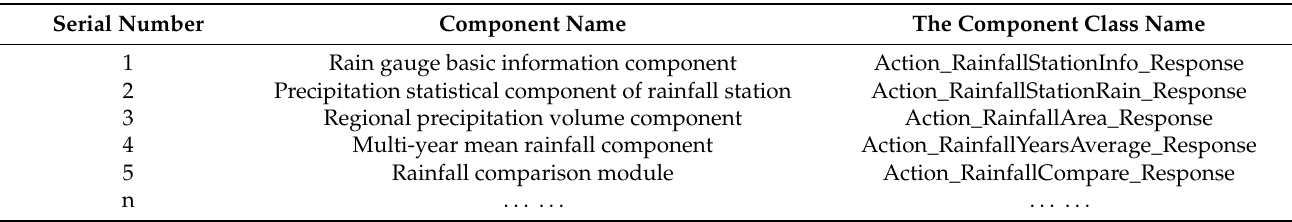
Table 2. Core components of